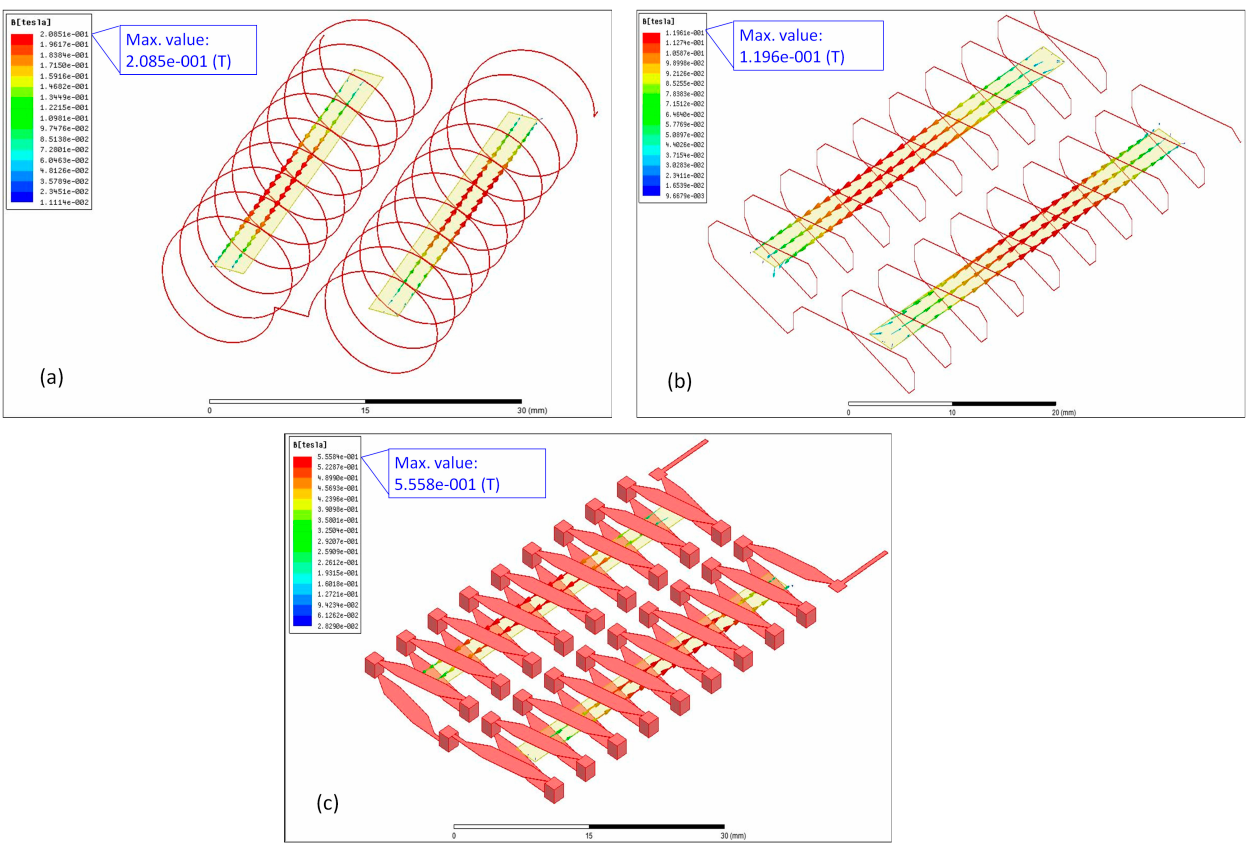
Figure 3. 3-D modeling and simulation results of ( a ) cylindrical, wire-wound excitation coils; ( b ) rectangular, wire-wound excitation coils; and ( c ) rectangular, thick-film excitation coils by “flip chip”